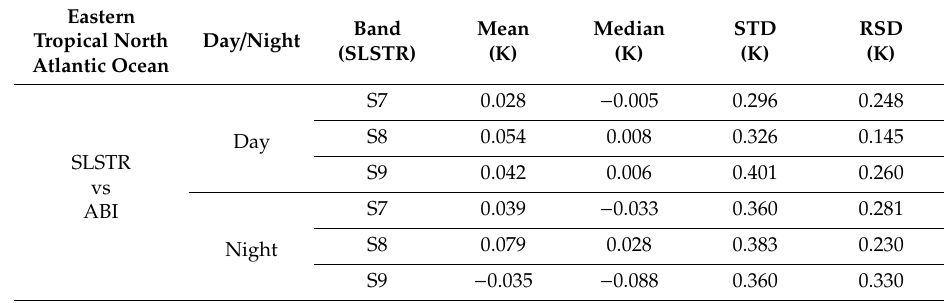
Table 4. Statistics of SLSTR BTs minus ABI equivalent BTs in eastern tropical North Atlantic Ocean. STD: standard deviation. RSD: robust standard deviation.